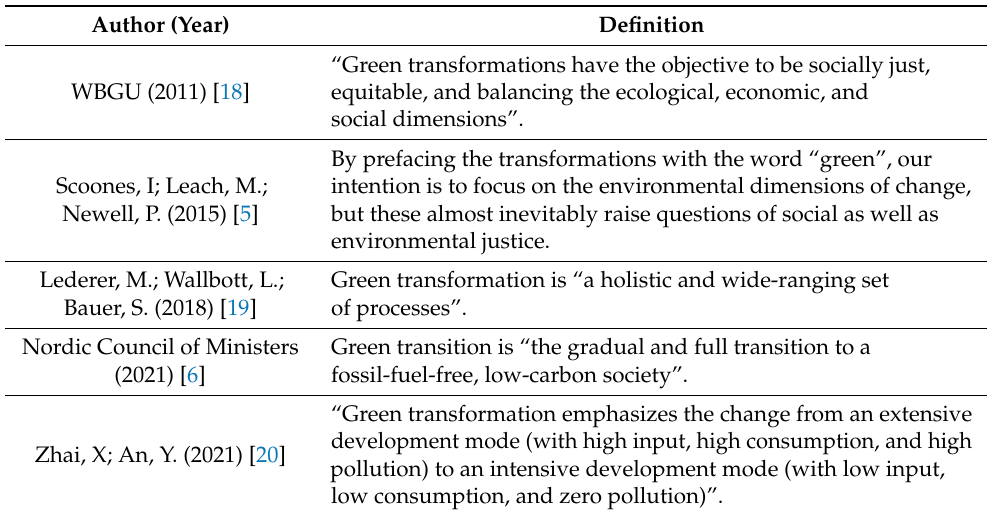
Table 1. Definition and description of green transition and green transformation.